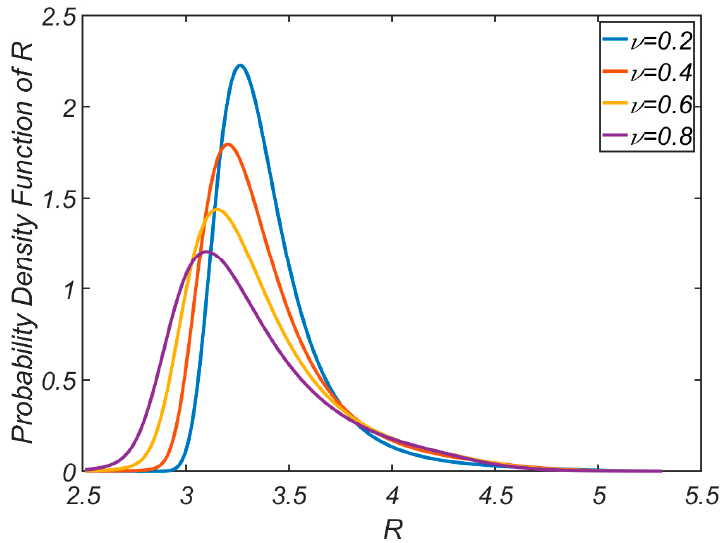
Figure 18. Weakened hydraulic stability strength of armor block as sea wave conditions are becoming harsh.